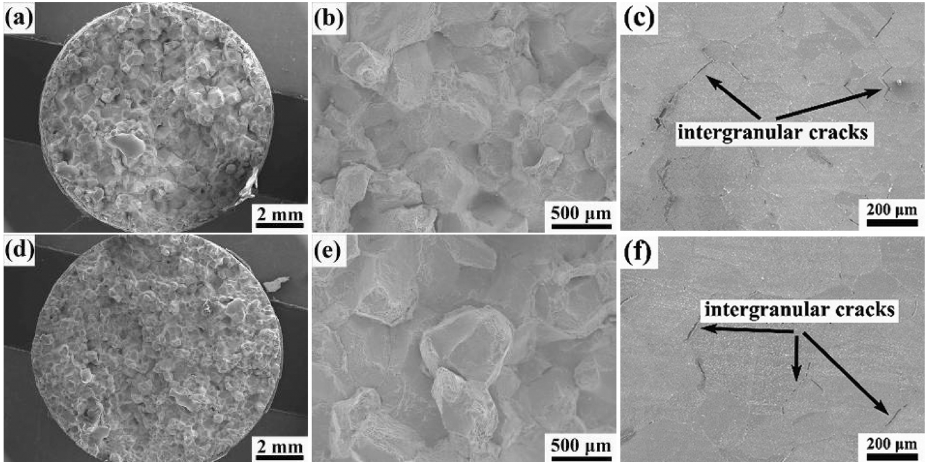
Figure 3: The fractures of the investigated alloys tested at 900°C in Zone II: (a – c) The macrostructure, microstructure and longitudinal microstructure of the fracture morphology of alloy B0; (d – f) the macrostructure, microstructure and longitudinal microstructure of the fracture morphology of alloy B1.